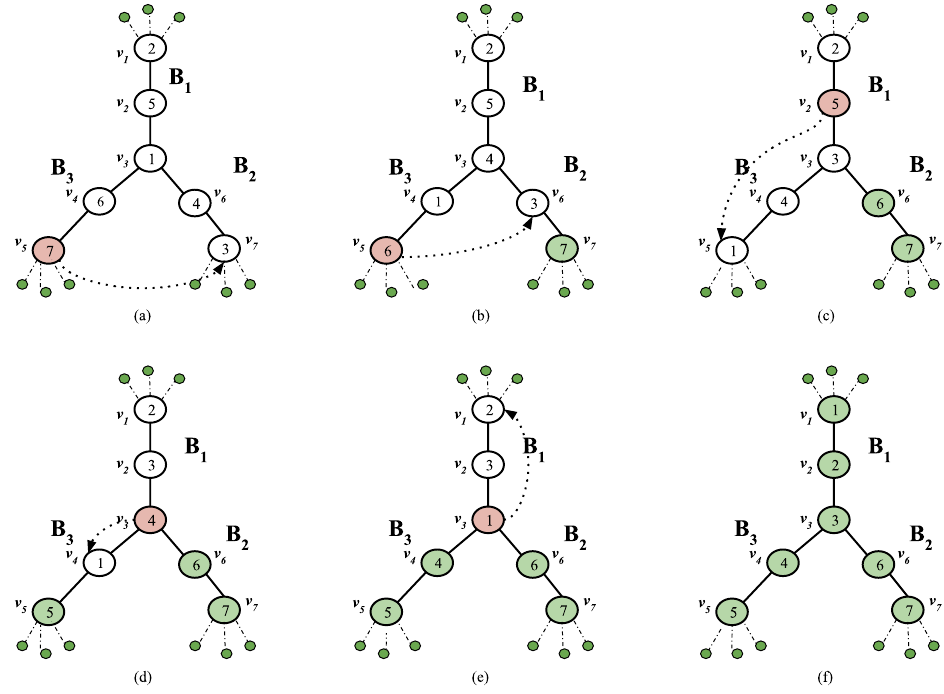
Figure 11. Another possible swap sequence of path markers on the 3-Broom shown in Figure 10a. ( a ) Homing 7, Swaps = 4. ( b ) Homing 6, Swaps = 3. ( c ) Homing 5, Swaps = 3. ( d ) Homing 4, Swaps = 1. ( e ) Homing 1, Swaps = 2. ( f ) All markers are homed. Total Swaps =